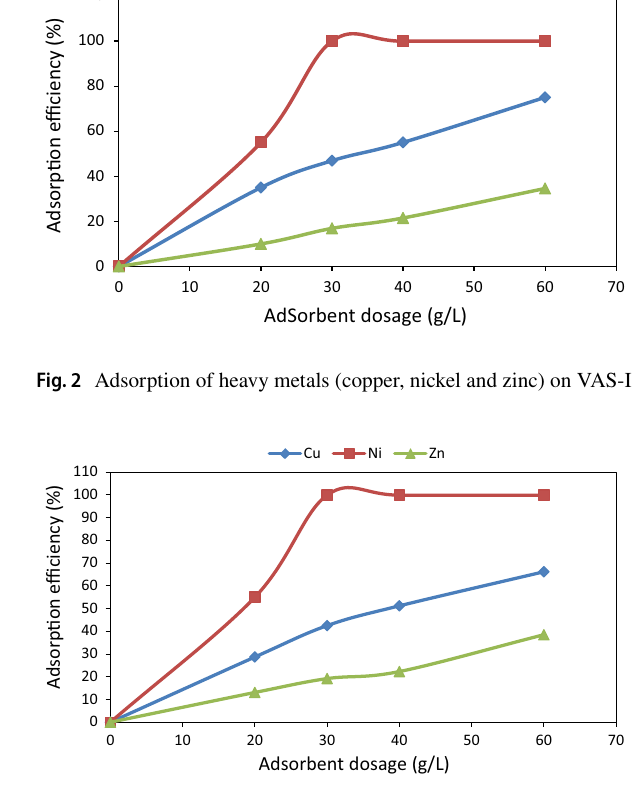
Fig. 3 Adsorption of heavy metals (copper, nickel and zinc) on VAS-